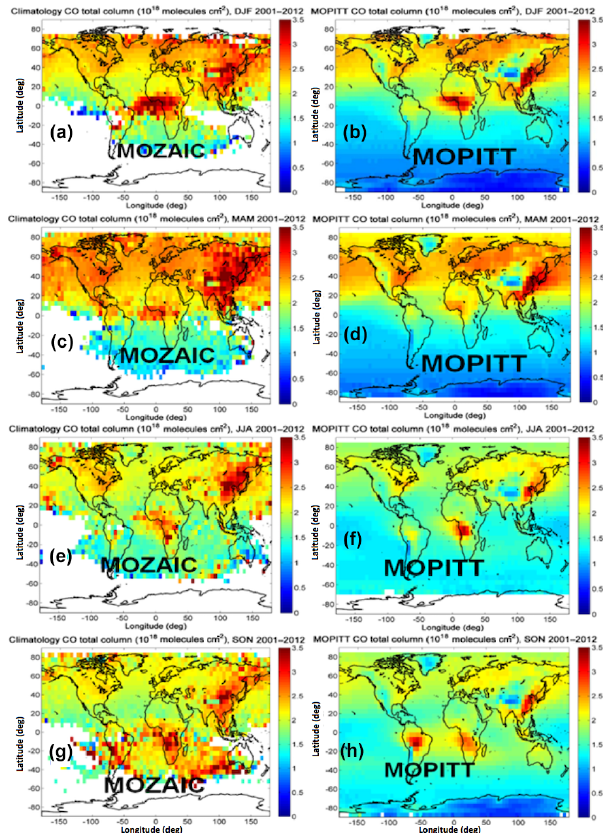
Figure 12. Global total column CO from the transformed trajectory- mapped MOZAIC-IAGOS climatology and MOPITT data for December–February, March–May, June–August, and September– November 2001–2012. Data are averaged in 5 ◦ × 5 ◦ latitude– longitude